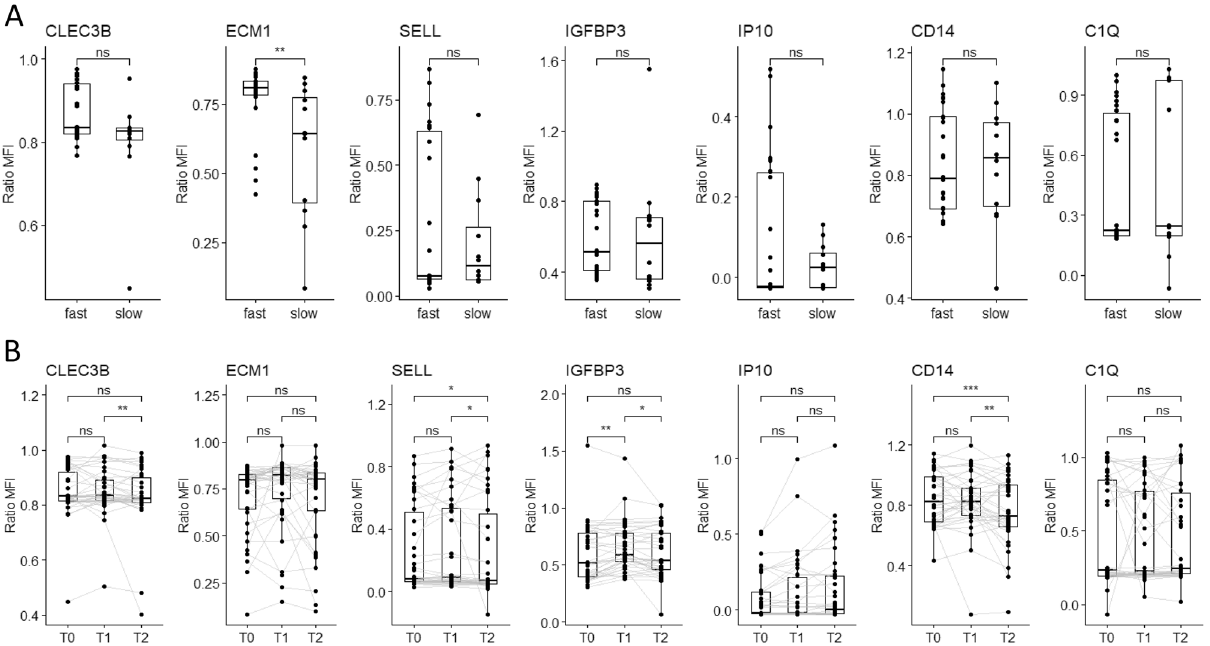
Figure 3. Plasma markers levels for treatment monitoring. ( A ) Comparison of markers expression in Fast vs Slow. ( B ) Dynamics of plasma markers over the course of TB therapy (n = 37 per timepoint). Data are given as median with interquartile range. Each black dot represents one patient, Grey lines connect data points from the same patient T0: baseline. T1: baseline + 2 months. T2: end of treatment. Data were compared using the Wilcoxon–paired test or Mann-Whithney U test with correction apply to adjust p values. * p < 0.05; ** p < 0.01; *** p < 0.001.